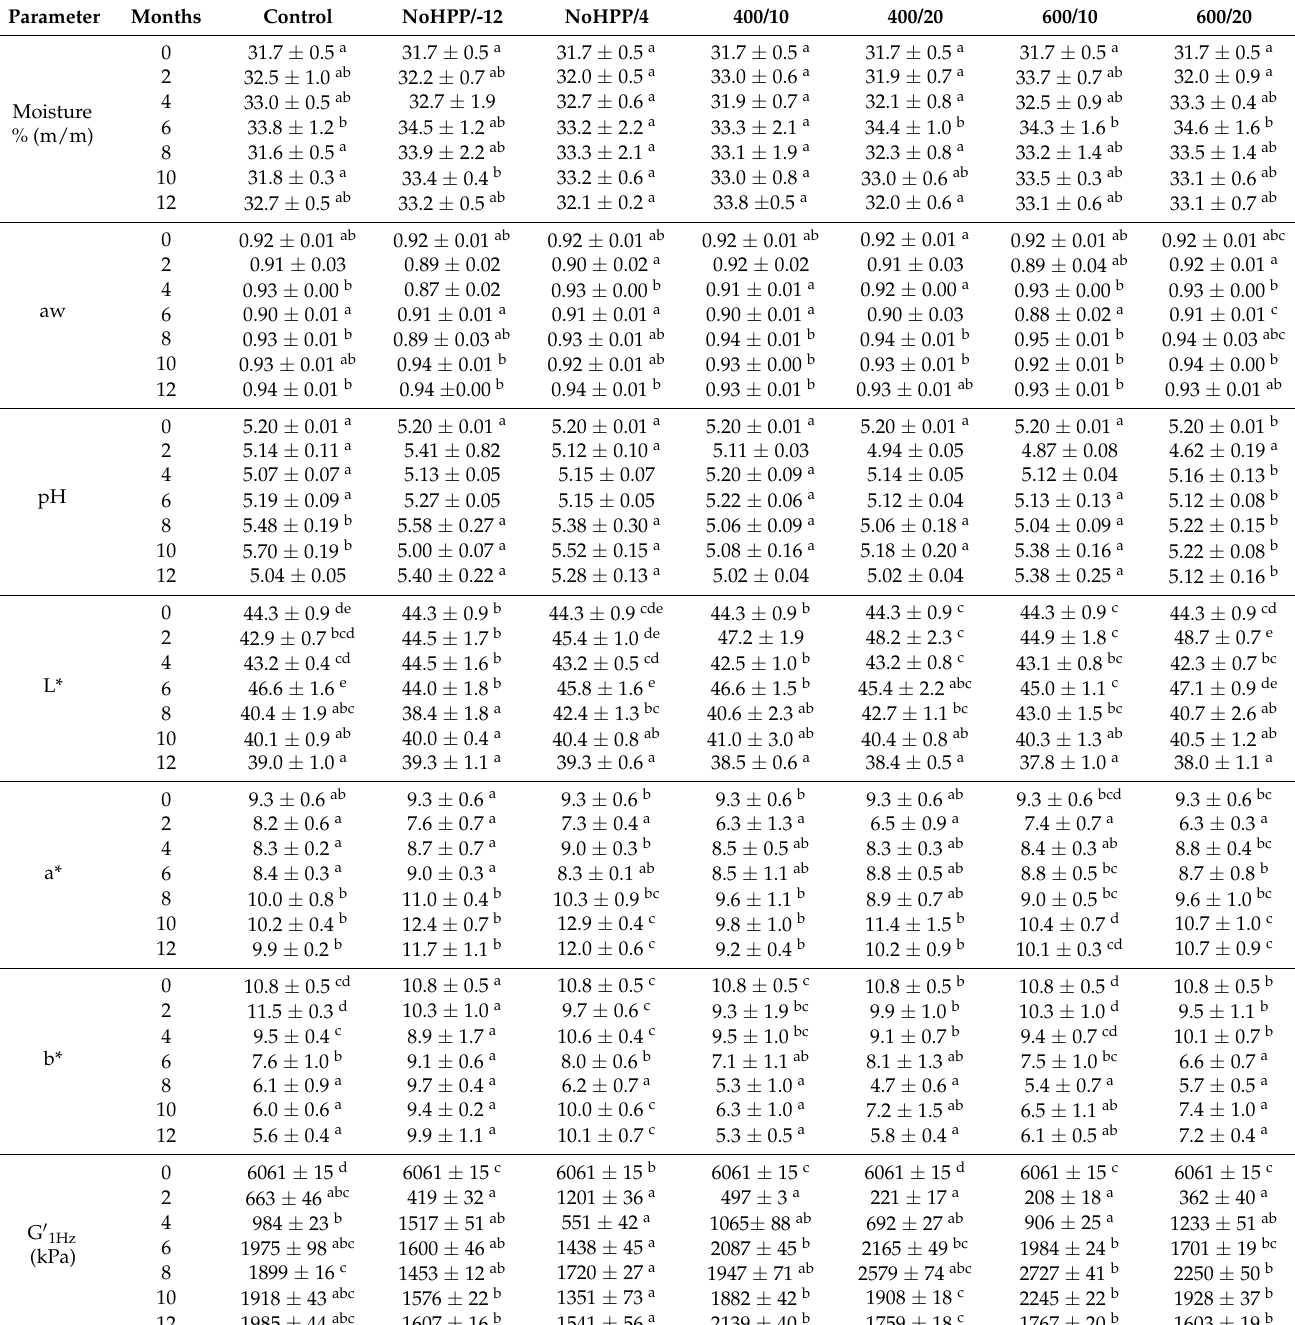
Table 2. Impact of different processing and storage conditions on moisture, aw, pH and colour parameters of chocolate fillings. The values are presented as mean ± standard